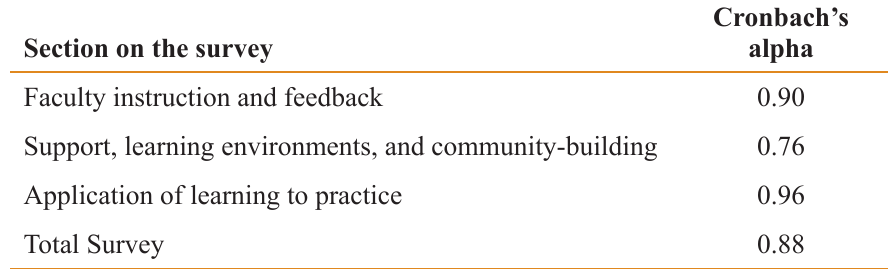
Internal Consistency/Reliability of the